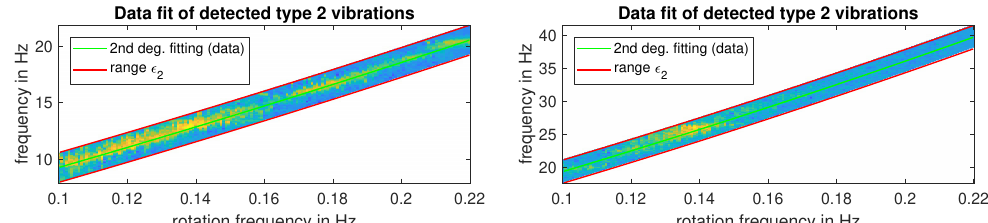
Figure 10. Refinement of detected Type 2 vibrations by using 2nd degree models, examples shown for vibration V 2,3 ( left ) and V 2,5 ( right ) of an exemplary sensor. Model range (cid:101) 2 was identified by using vibration scanning and vibration filtering, as described in Figure 8. Robust fitting with spectrogram amplitudes was used as weights, with coloured areas within range (cid:101) 2 corresponding to non-zero